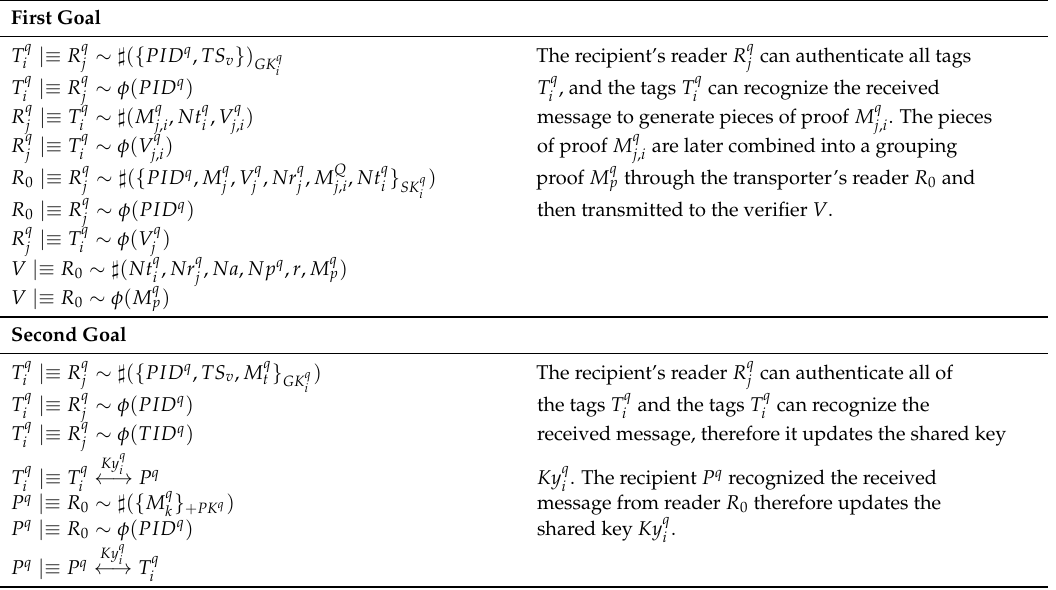
Table 9. Goals of the proposed